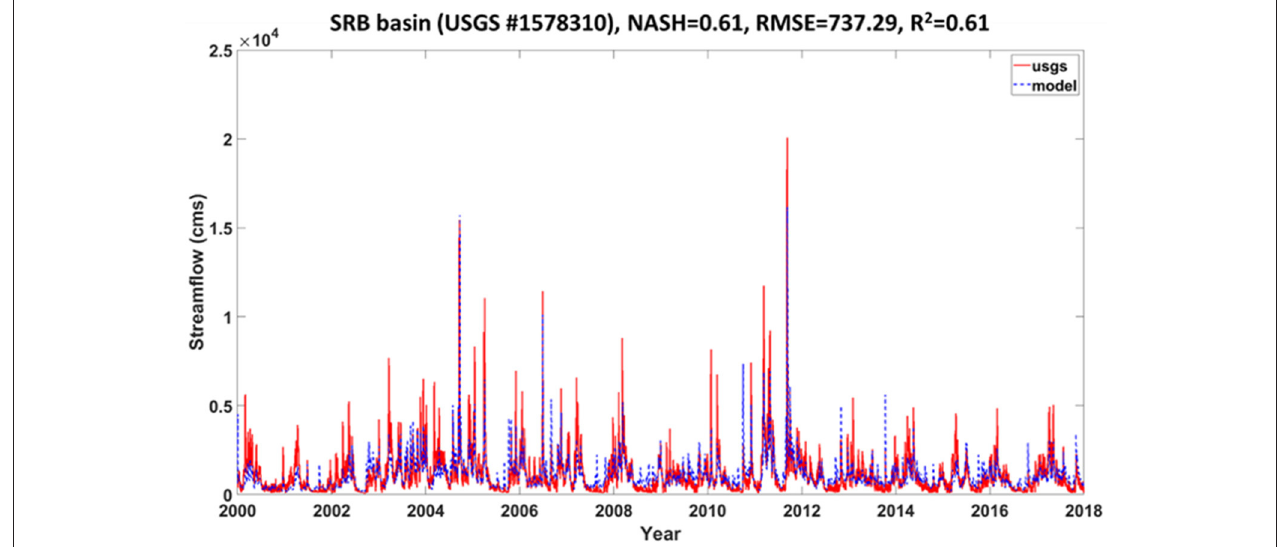
FIGURE 5 | Model streamflow simulation of whole SRB streamflow simulation. The red solid line indicates the USGS measured streamflow, and the blue dashed line indicates the model’s simulated